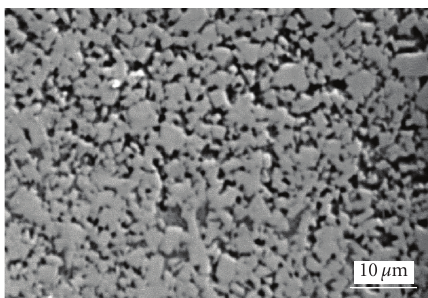
Figure 4: Microstructure of the optimized coating FD 115-SD 300;